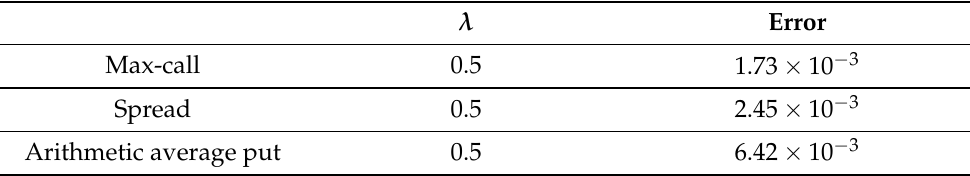
Figure 8. Two-Asset spread American option value in a reduced domain ( left ). Difference between the ANN solution and the payoff function ( right ). Table 8. Error for different multi-asset American